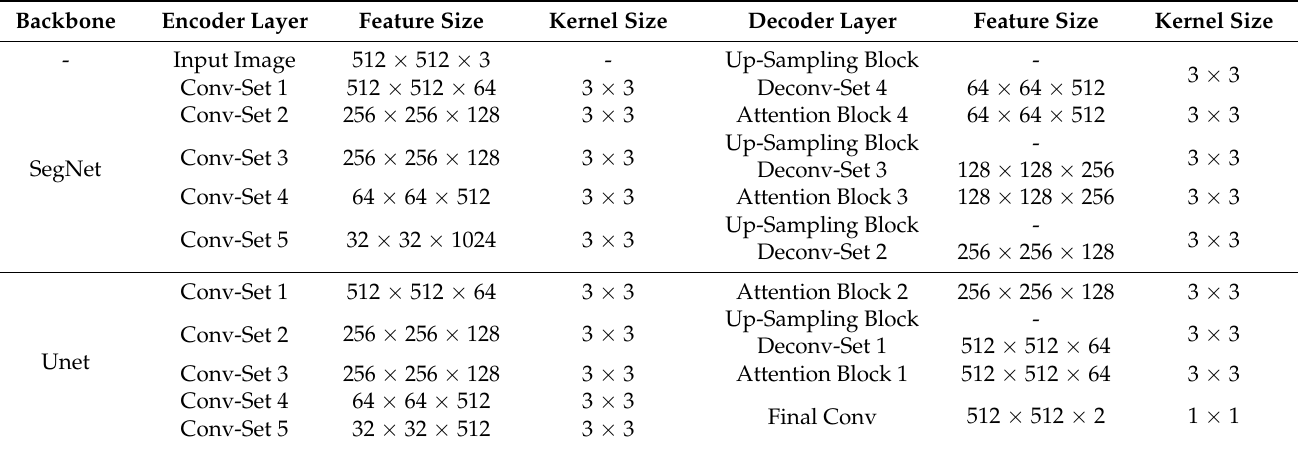
Table 1. Parameters and feature size of the proposed framework. The feature size shows the framework has symmetrical architecture and attention blocks do not change feature